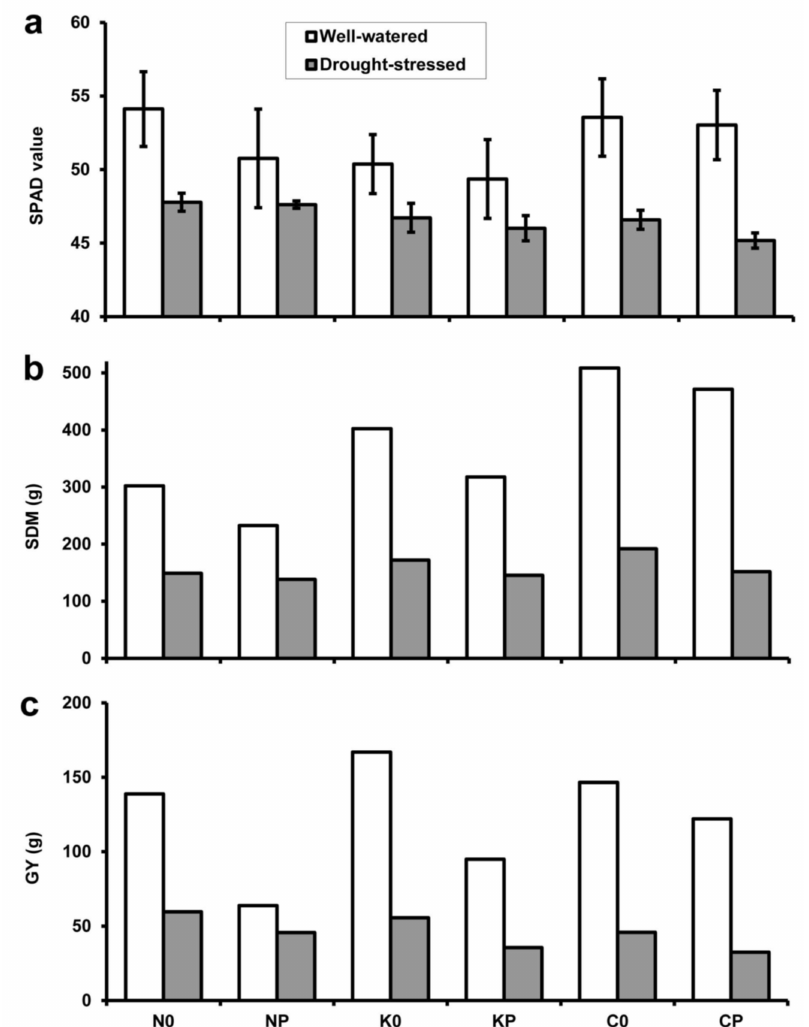
Figure 4. ( a ) Leaf chlorophyll content as SPAD value (mean ± SD; n = 15), ( b ) total shoot dry mass (SDM) and ( c ) total grain yield (GY) under well-watered (white columns) and drought-stressed (grey columns) conditions. For treatment codes, see Figure